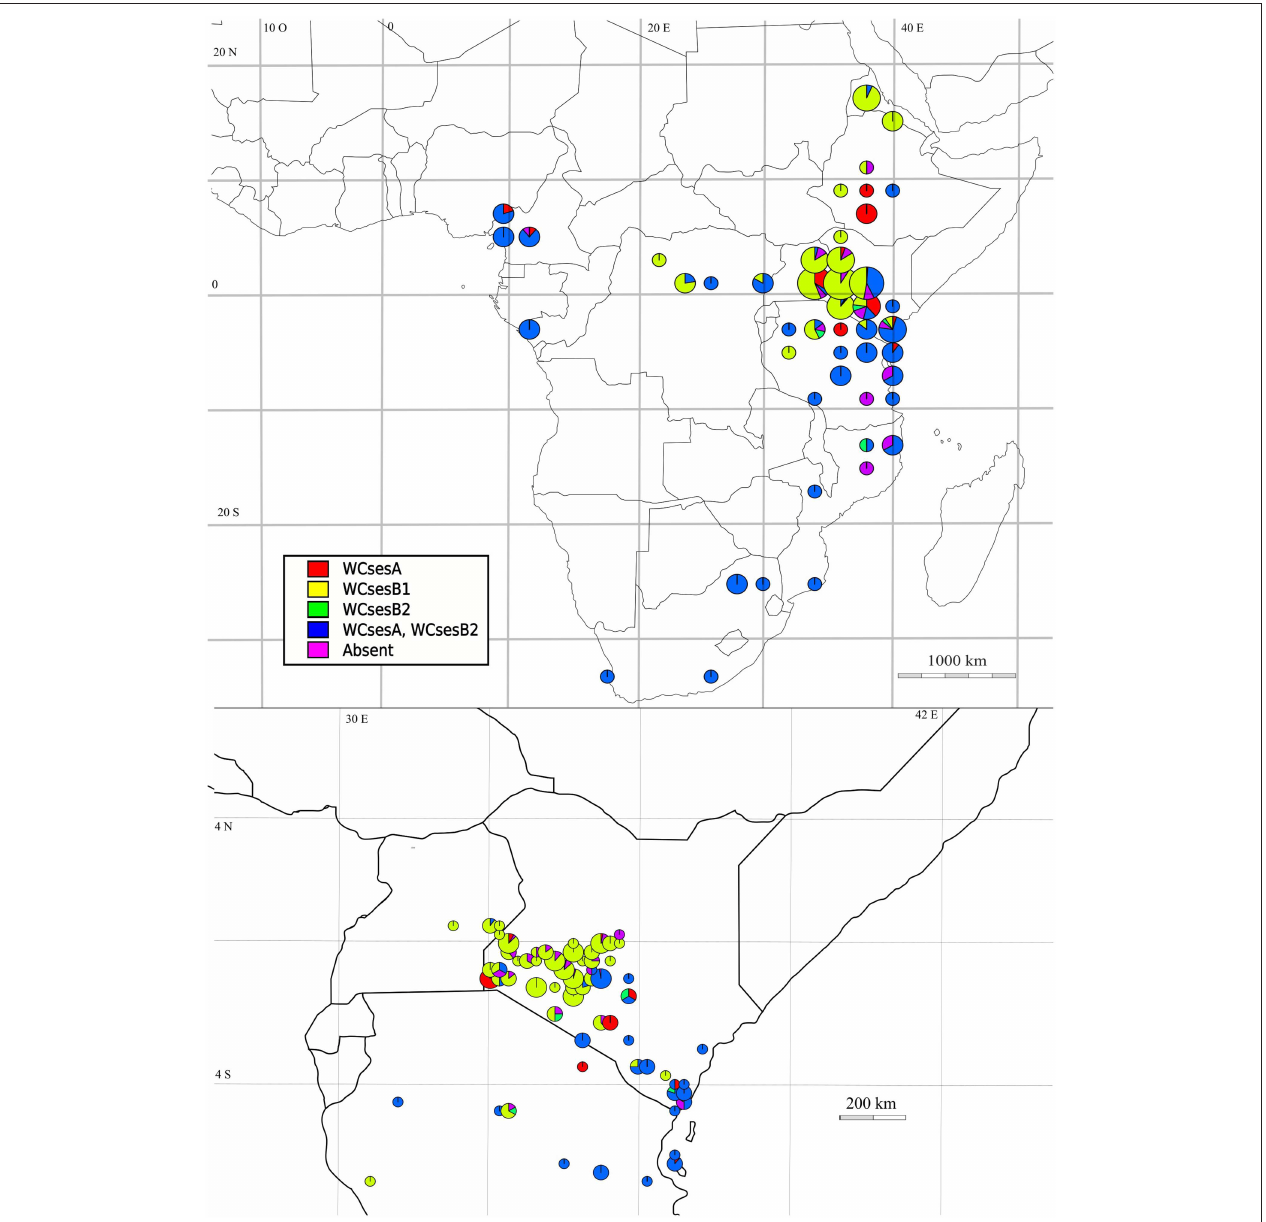
FIGURE 3 | Distribution of Wolbachia infection in Cotesia sesamiae wasps across Sub-Saharan Africa (top) and Kenya (bottom). WCses A in red; WCses B1 in yellow; WCses B2 in green; WCses A/WCses B2 in blue; Absence in magenta.